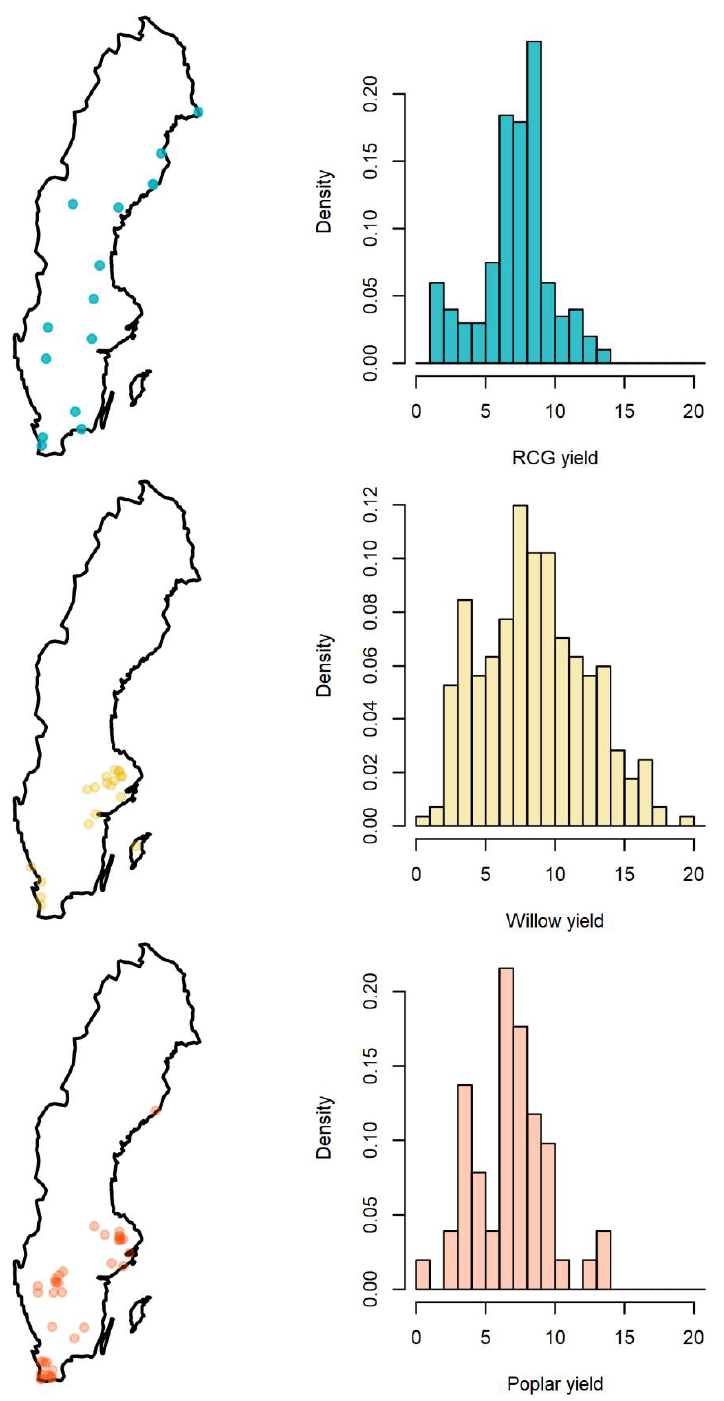
Figure 4. Estimated distribution of yields (odt ha −1 year −1 ) for reed canary grass compared to willow and poplar in different trials along the country (see maps) for the period of 1991–2010. The yields from trials, however, are largely overestimating the commercial yield of RCG, estimated around 3.37 odt ha −1 year −1 in Sweden (Figure 5). Nearby areas in Finland present similar values for commercial plantations, for example, around 3.6 in Lapland and 4.2 in South Ostrobothnia. The Finnish average is even lower (3.1 odt ha −1 year −1 ). The cor- responding values for commercial willow plantations in Sweden are 2.6 odt ha −1 year −1 and 4.2 odt ha −1 year −1 for the first and second rotation, respectively.